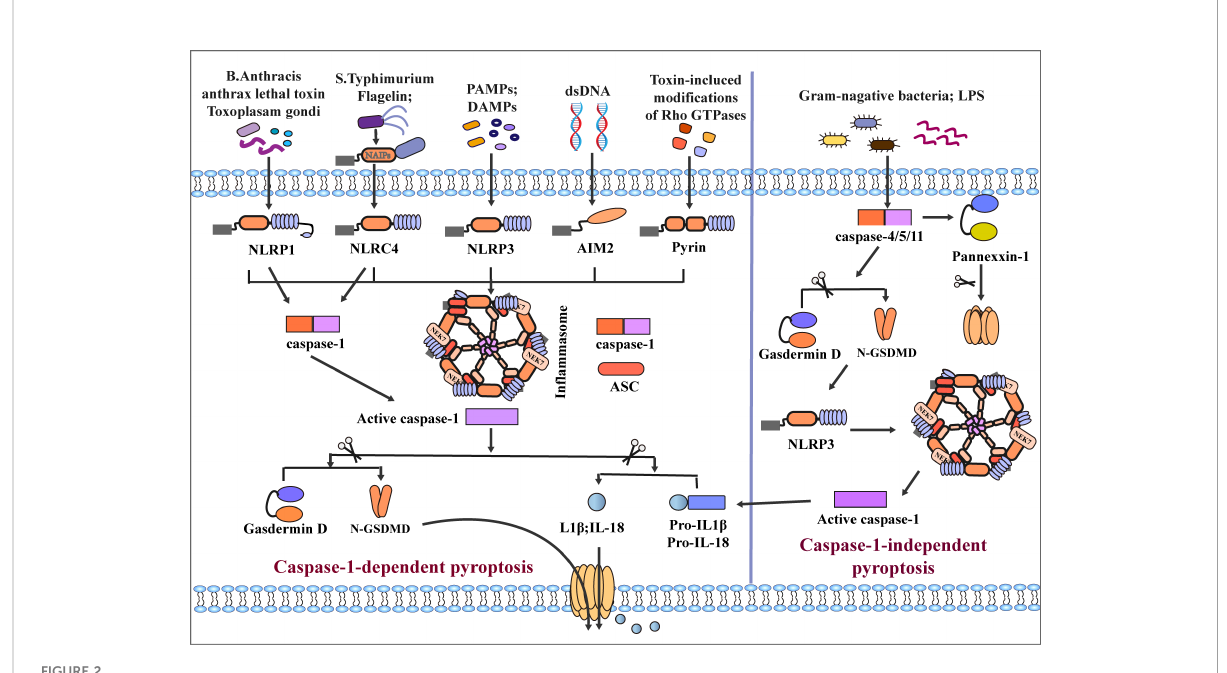
FIGURE 2 Classical and non-classical in fl ammasome assembly. The canonical pathway is mediated by caspase-1. When NLRP1, NLRC4, NLRP3, AIM, and Pyrin in fl ammatory sensors receive different stimuli, recruiting ASC and caspase-1 to mediate the assembly of in fl ammasomes and activate caspase-1. Among them, the assembly of NLRP3 and NLRC4 in fl ammasomes requires the participation of NEK7 and NAIPs, respectively, and NLRP1 and NLRC4 can directly activate case page-1 due to their CARD domains. After activation of Caspase-1, GSDMD and pro-IL-1 b /18 is cleaved, and the pore formed by GSDMD on the cell membrane surface mediates secretion of IL-1 b /18 out of the cell and induces pyroptosis. The non-canonical pathway is mediated by caspase-4/5/11; LPS of Gram-negative bacteria directly induces caspase-4/5/11 activation and cleaves GSDMD and Pannexin-1. N-GSDMD induces caspase-1 activation by activating NLRP3 in fl ammasome assembly, which mediates the release of in fl ammatory mediators and